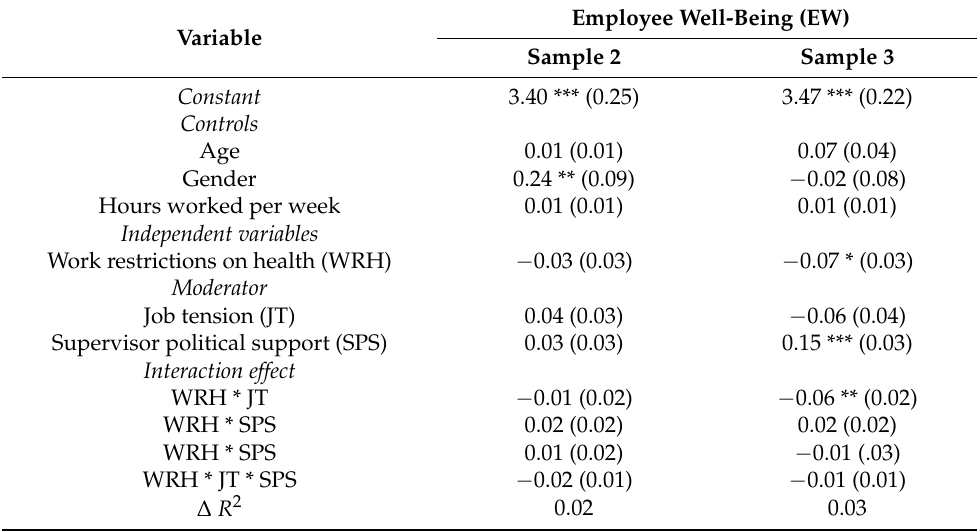
Table 4. Results of three-way interaction of work restriction on health predicting employee well-being.